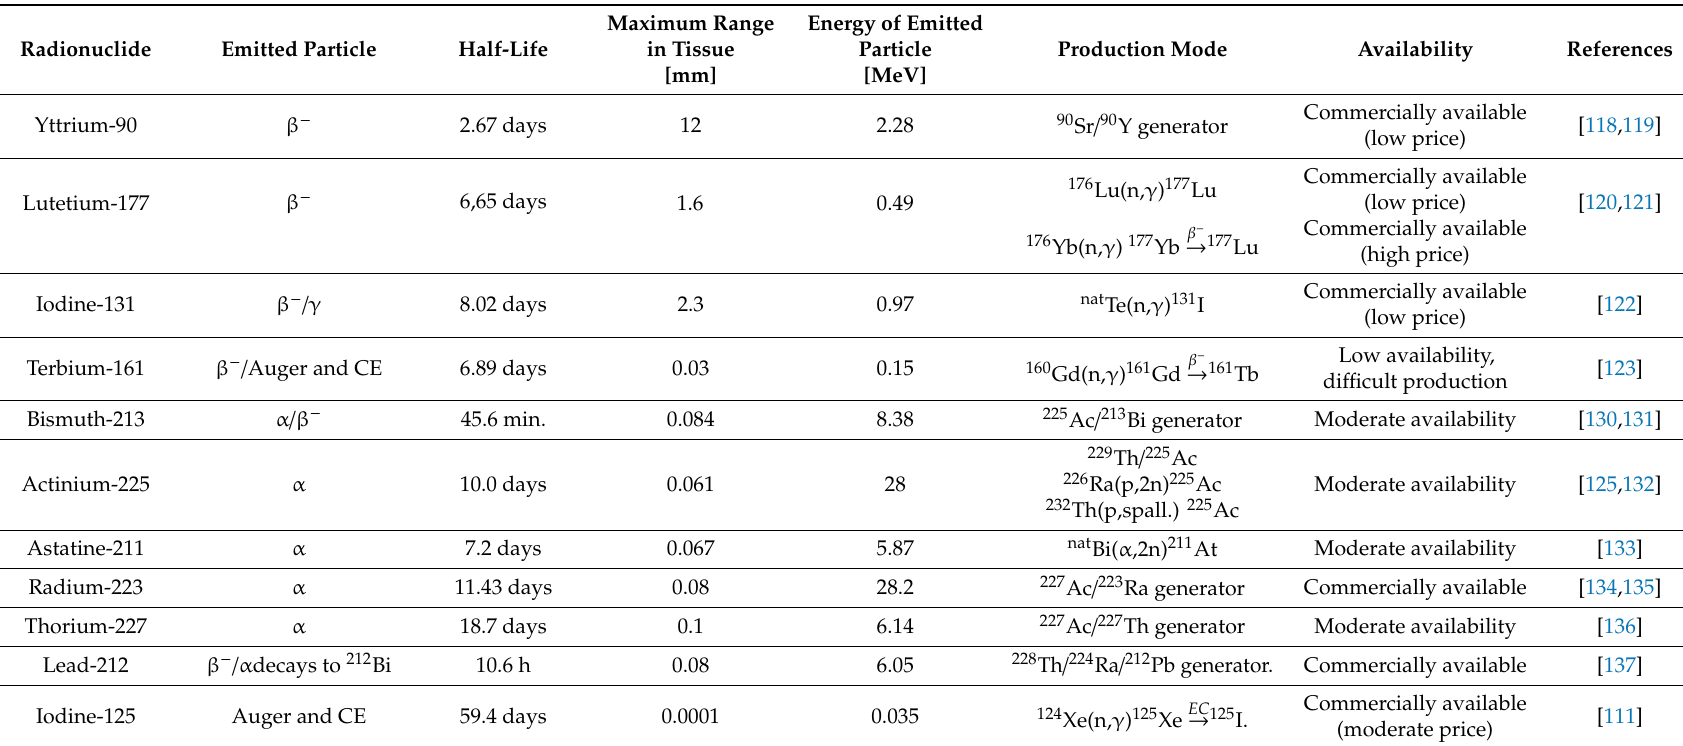
Table 1. Beta − -particle, alpha-particle, and Auger electron-emitting radionuclides for targeted prostate cancer